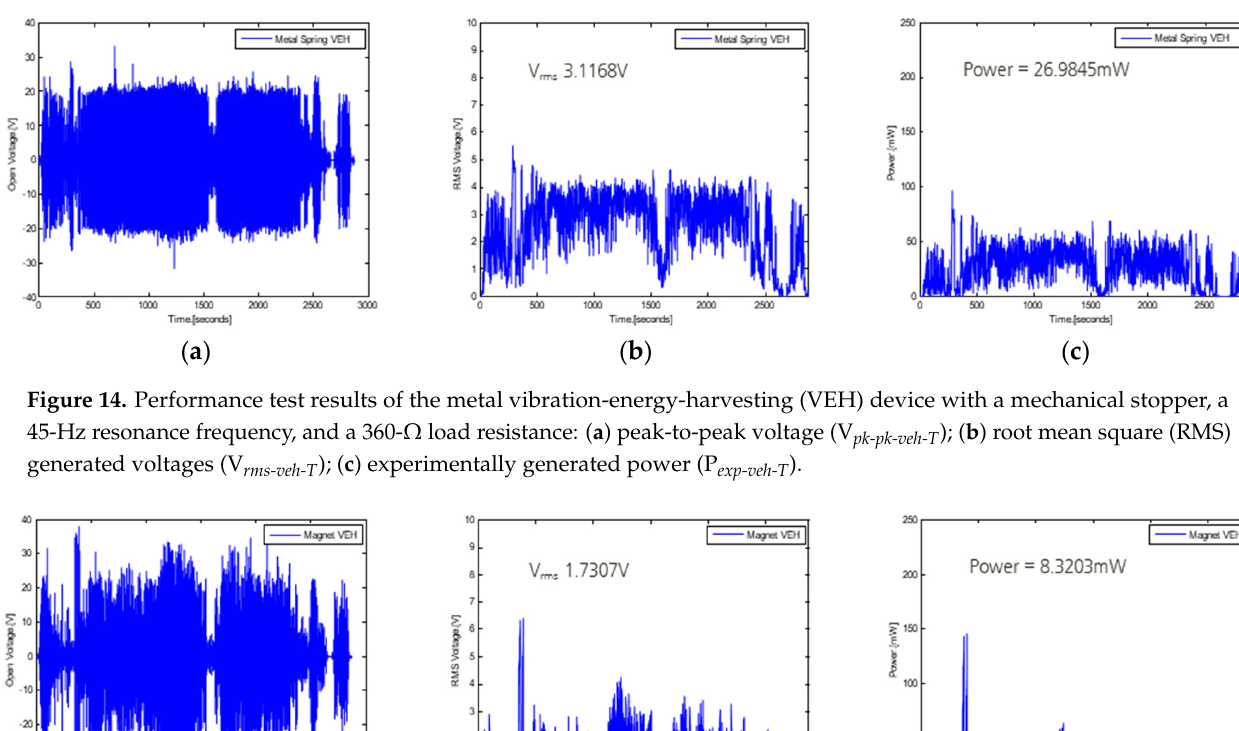
Figure 13. The VEH devices for the high-speed train test: ( a ) installation of two VEH devices on the axle box, where only the springs differed between the magnetic spring VEH device (bottom of the jig) and metal spring VEH device (top of the jig). The design of the resonance frequency of the two VEH devices was similar, approximately 45 Hz; ( b ) voltage measurement system in the cabin.